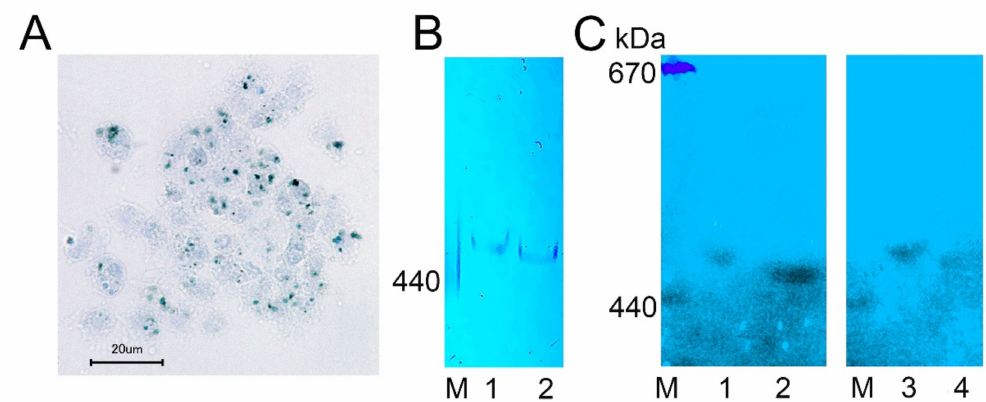
Figure 6. Ferritin complexes in sponges H. dujardini and H. panicea . ( A ) The ferric complexes detected in H. dujardini cells by Prussian blue staining. ( B , C ) Sponge cell extracts fractionated by native electrophoresis in polyacrylamide gel: staining with Prussian blue ( B ) and the UV 360 nm absorbance ( C ). Specimens of H. panicea collected in Autumn (1) and Summer (3). Specimens of H. dujardini collected in Autumn (2) and Summer (4). M, horse ferritin (440 kDa) and thyroglobulin (670